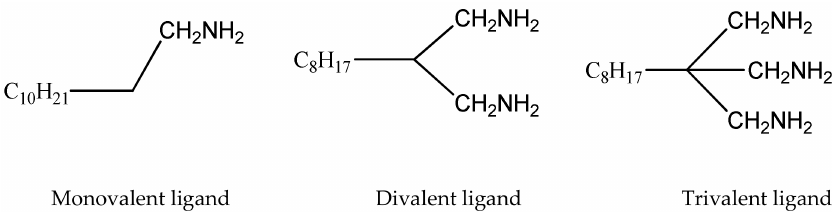
Figure 1. Chemical structures of dodecylamine (monovalent ligand), 2-octylpropane-1,3-diamine (divalent ligand), and 2-(aminomethyl)-2-octylpropane-1,3-diamine (trivalent